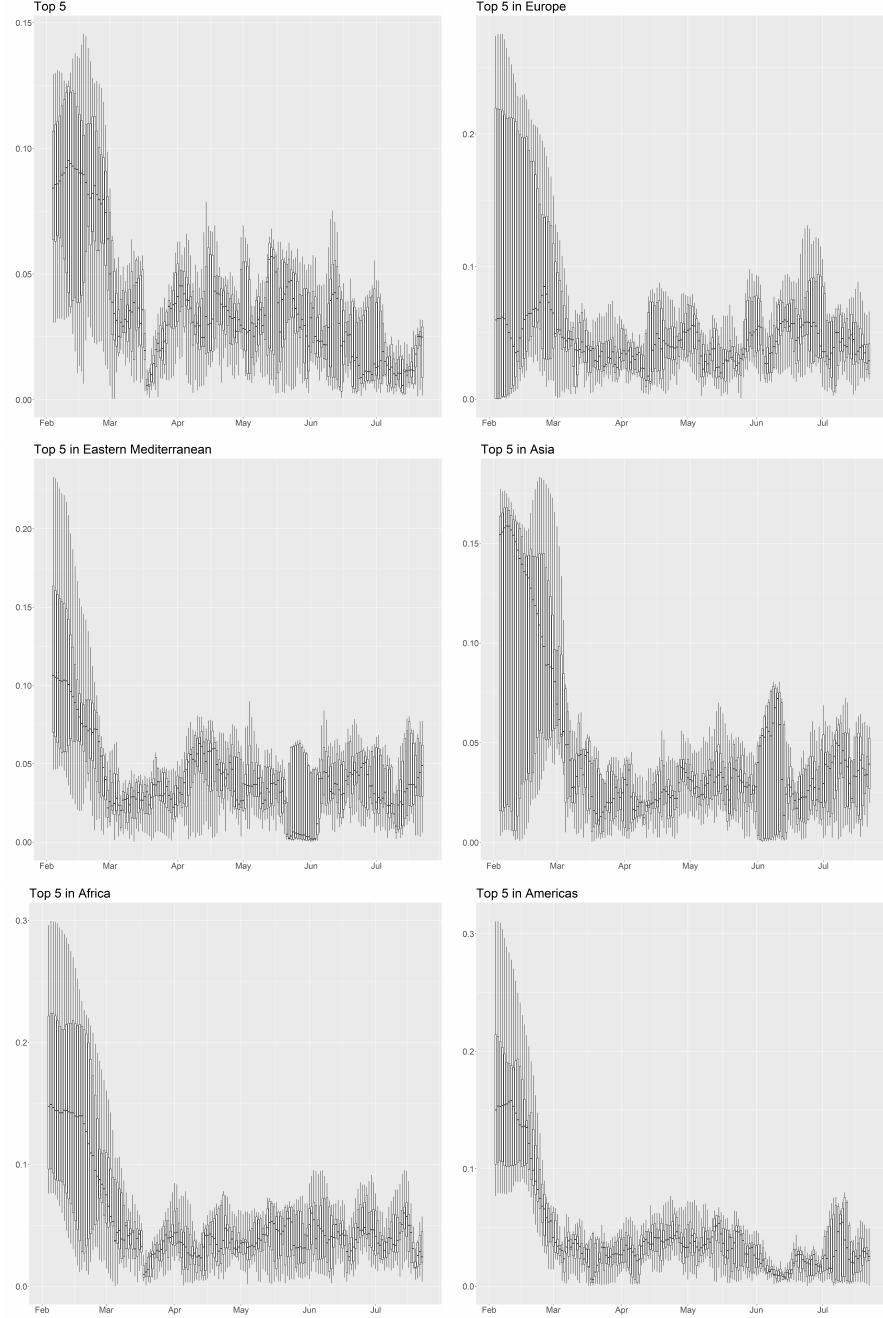
Figure 4. Time series of the boxplots of the distance among countries, which are in the top 5 in terms of the cumulative number of confirmed COVID-19 cases in the whole world or in each of the five